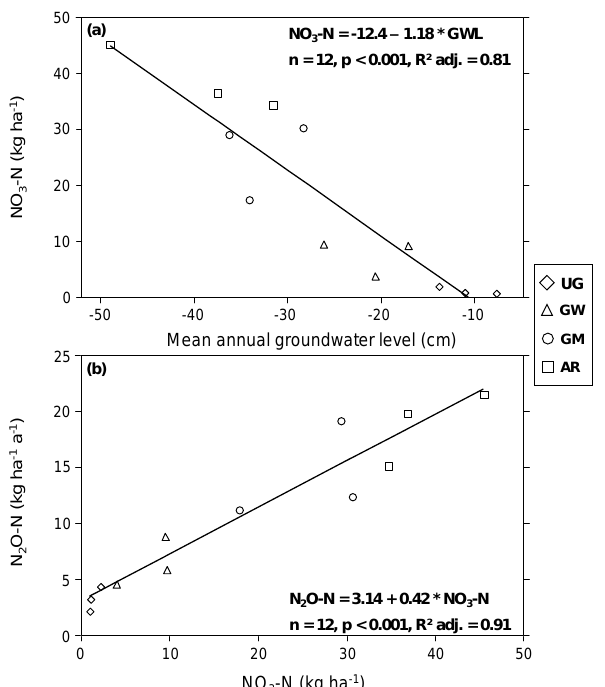
Figure 12. Effect of mean annual groundwater level on net ecosys- tem exchange (NEE) of CO 2 (a) and global warming potential (GWP) of the four study sites (b) during the period April 2012– March 2014. GWL in the equations is the mean annual groundwater level